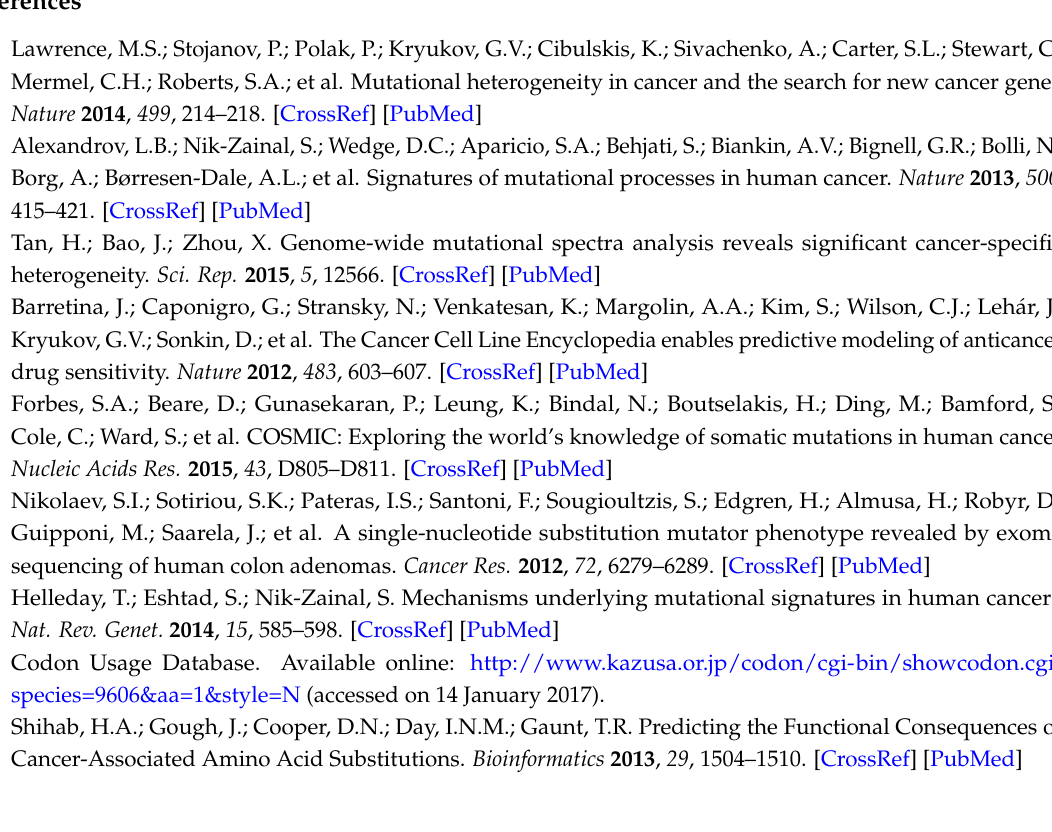
Figure S1: Difference in numbers of mutations between the GC and AT pairs of nucleotides in the COSMIC database, Figure S2: Rate of loss for each amino acid in the COSMIC database, Figure S3: Frequencies of gain/loss of amino acids due to coding substitutions in the analyzed proteome subset per 1000 samples in the COSMIC database, Figure S4: Rate of gain/loss for each amino acid in the COSMIC database, Figure S5: Net gain/loss of cysteine, histidine, arginine and tryptophan in the analyzed subset of the proteome per sample in 23 tissues in the COSMIC database, Table S1: Codon frequencies in the human proteome, Table S2: Statistics of coding mutations per tissue in the analyzed subset of the proteome in the COSMIC database, Table S3: Gain/loss of the four amino acids calculated as percentage of the net gain/loss to the total number of mutations per tissue in the analyzed subset of the proteome in the COSMIC database, Table S4: Top frequencies of shared positions of substitutions of arginine in individual proteins in the CCLE database, Table S5: Top frequencies of shared positions of substitutions of arginine in individual proteins in the COSMIC